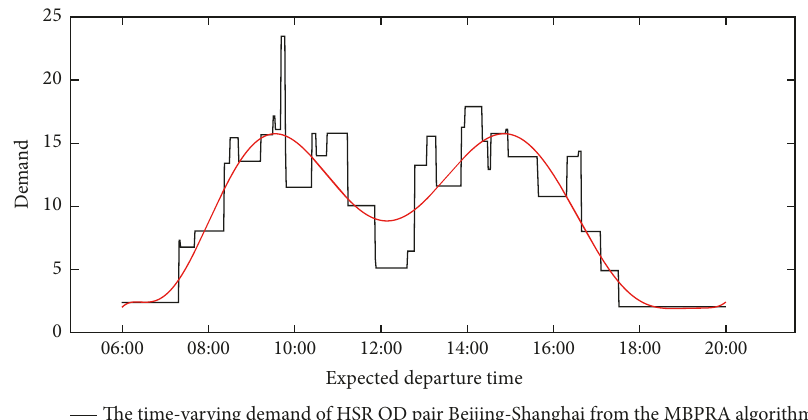
The time-varying demand of HSR OD pair Beijing-Shanghai from the MBPRA algorithm Polynomial fitting for the time-varying demand from the MBPRA Figure 15: Polynomial fitting for the result of the MBPRA algorithm of OD pair